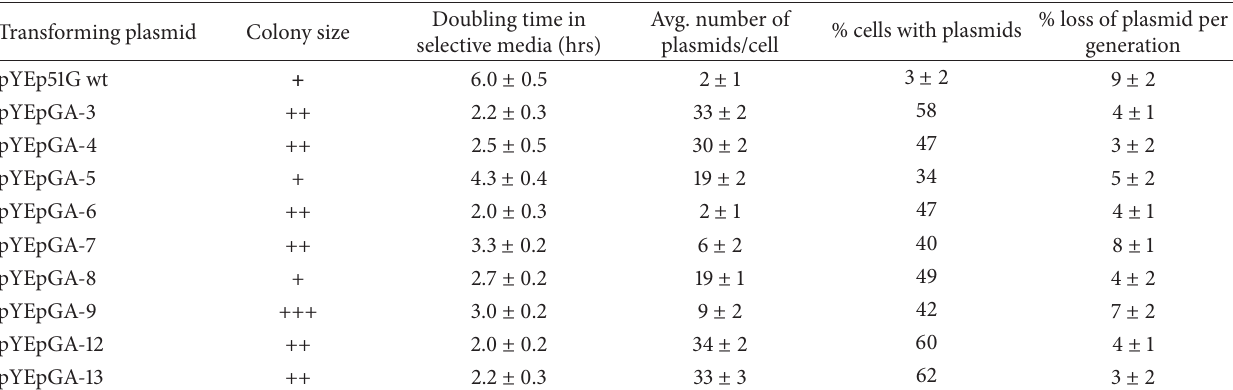
Table 7: Assessment of mitotic stability of the